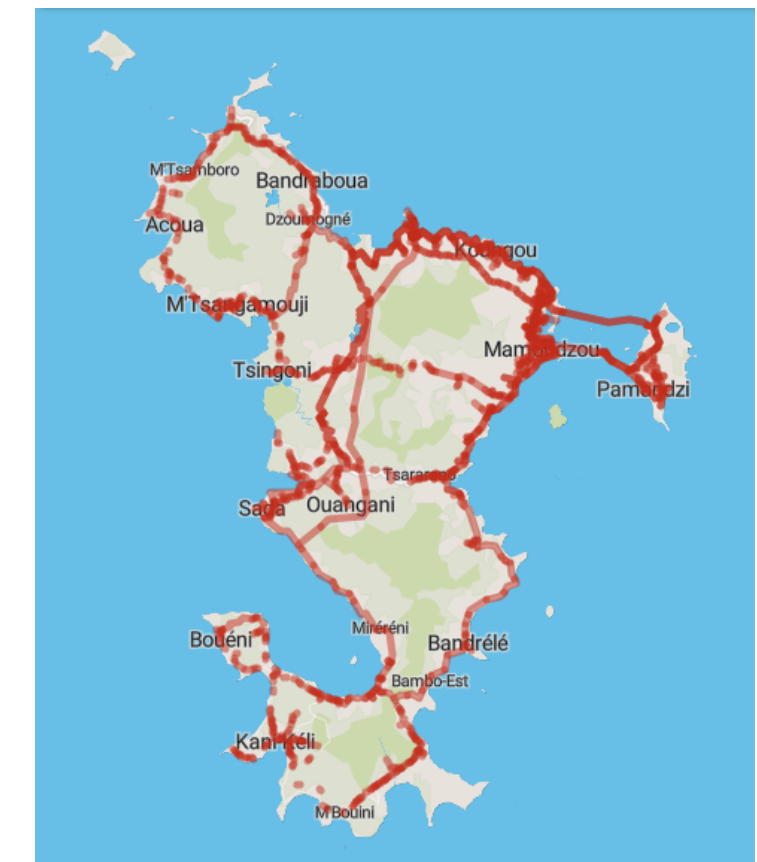
Figure 2. Electric low voltage network of Mayotte from EDM Open Data 2021©.